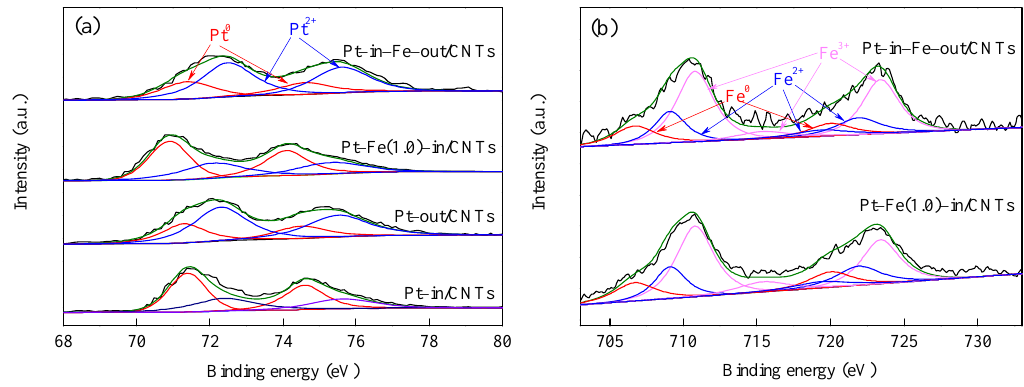
Figure 5. XPS spectra of Pt–in/CNTs, Pt–out/CNTs, Pt–Fe(1.0)–in/CNTs, and Pt–in–Fe–out/CNTs. ( a ) Pt4f; ( b ) Fe2p.